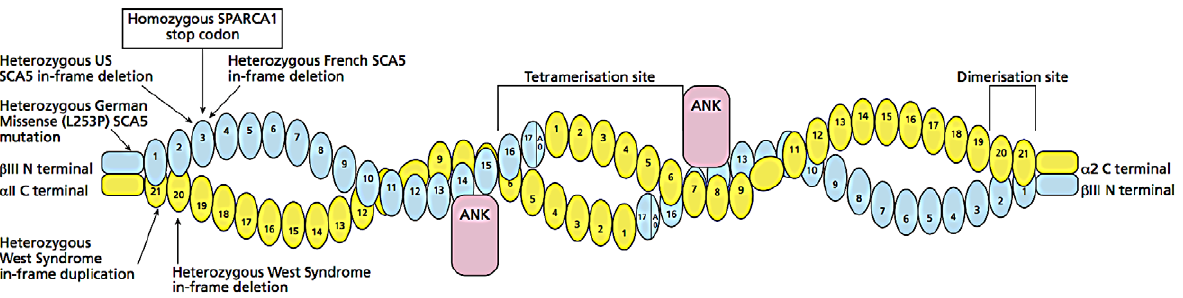
Figure 7. Diagram of b -III spectrin/ a -II spectrin tetramer. This is composed of 2 b -III spectrin and 2 a -II spectrin molecules and the location of the homozygous stop codon C627X in SPTBN2 causing SPARCA1 relative to dominant mutations in SPTBN2 and SPTAN1 . Mutations are only shown in one of the two molecules. Loss or truncation of b -III is likely to prevent formation of normal tetramers. The glutamate transporter, EAAT4, binds near the C terminus of b -III.